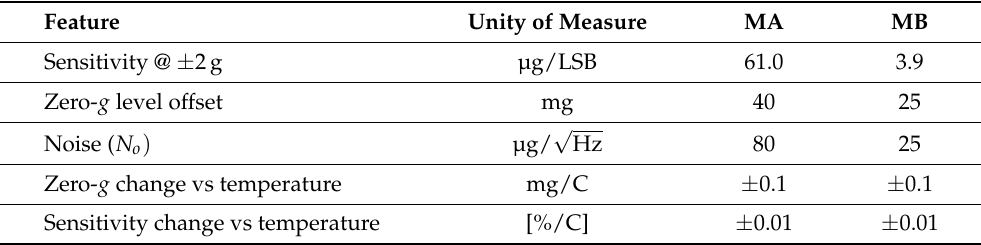
Table 1. Mechanical features of the considered MEMS accelerometer